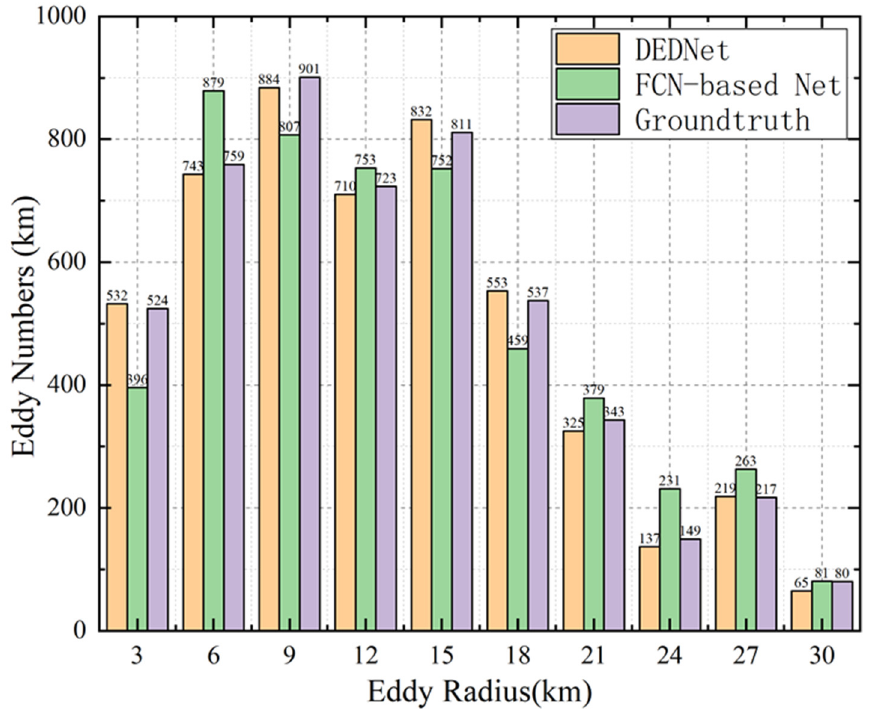
Figure 6. The eddy radius distribution detected by ground truth, FCN-based eddy network, and DEDNet.